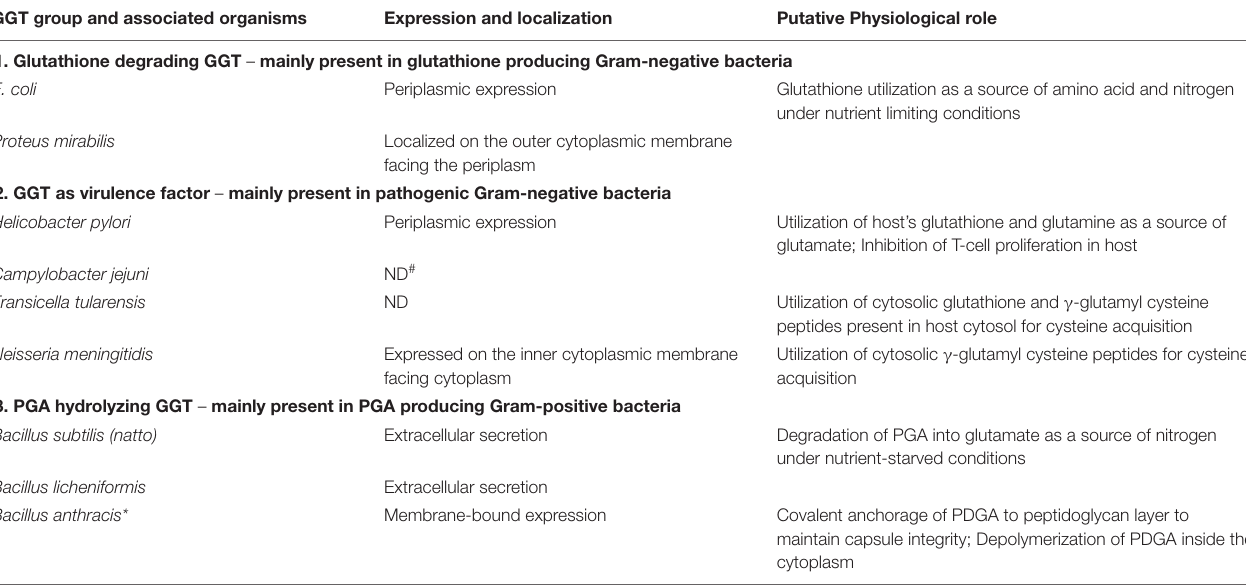
TABLE 1 | Classification of bacterial gamma-glutamyl transpeptidases (GGTs) into different physiological groups. GGT group and associated organisms Expression and localization Putative Physiological